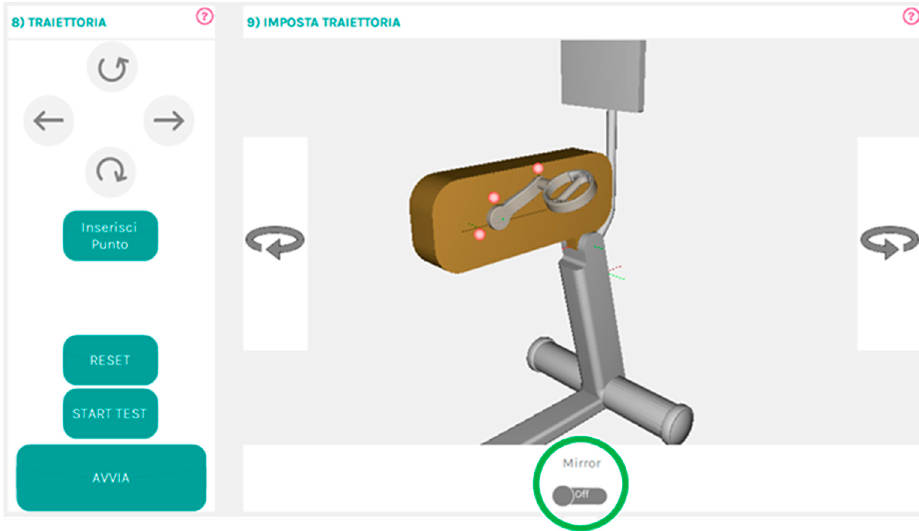
Figure 11. Detail of the Mirror Function switch on the LEPRE virtual console.